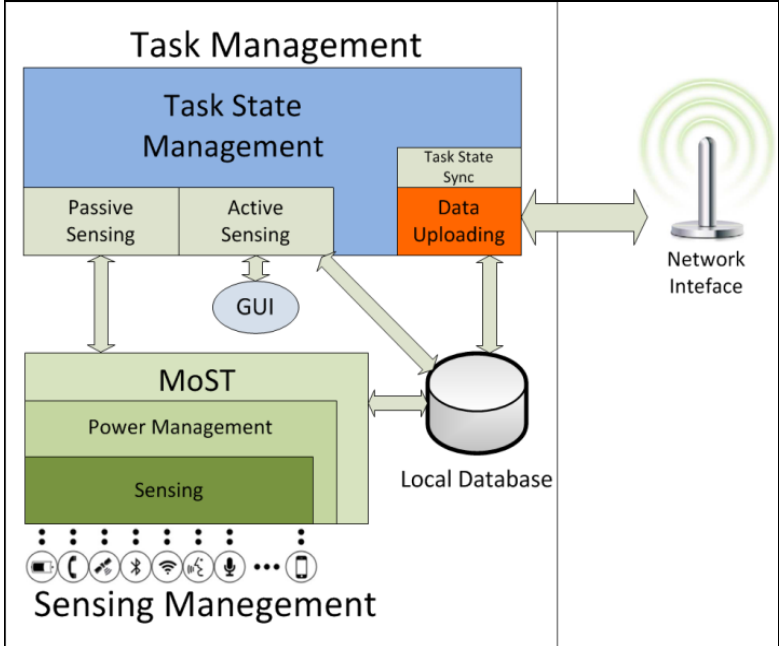
Figure 2. The architecture of the ParticipAct